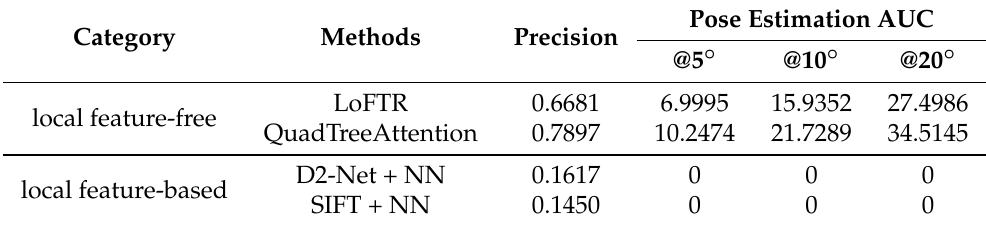
Table 6. Evaluation on test set for relative pose